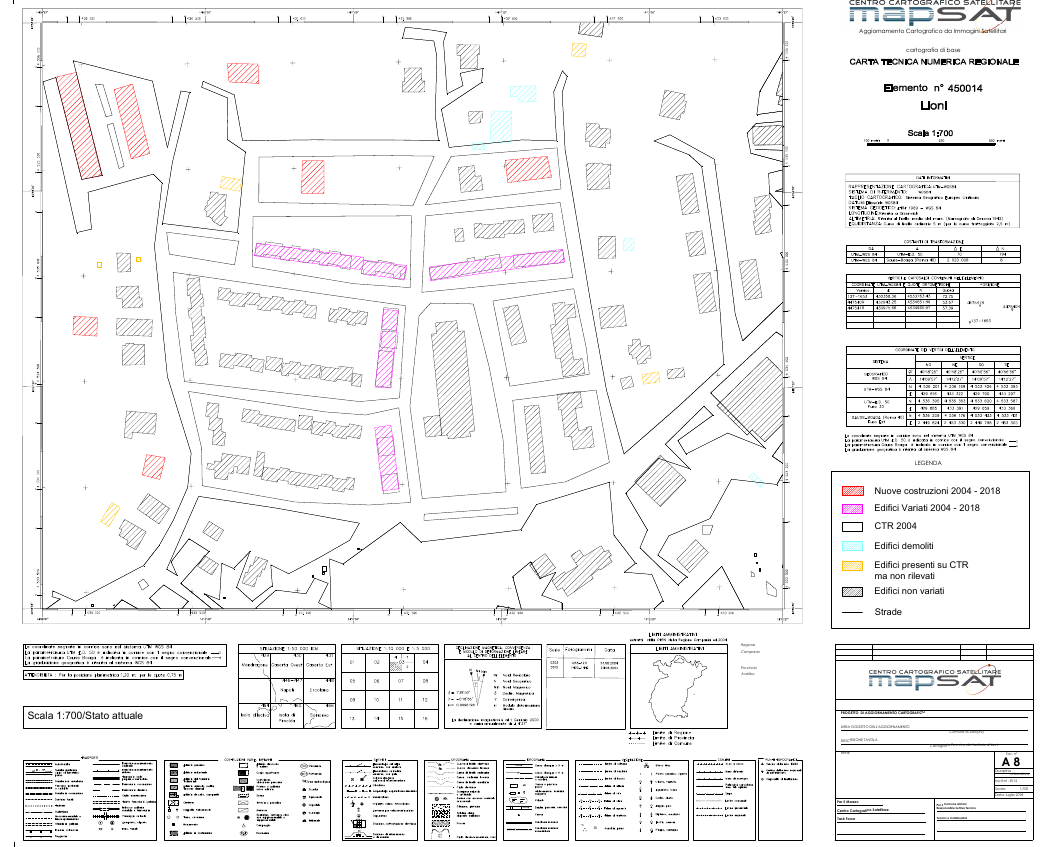
Figure 12. Updating of the CTR based on the results of proposed